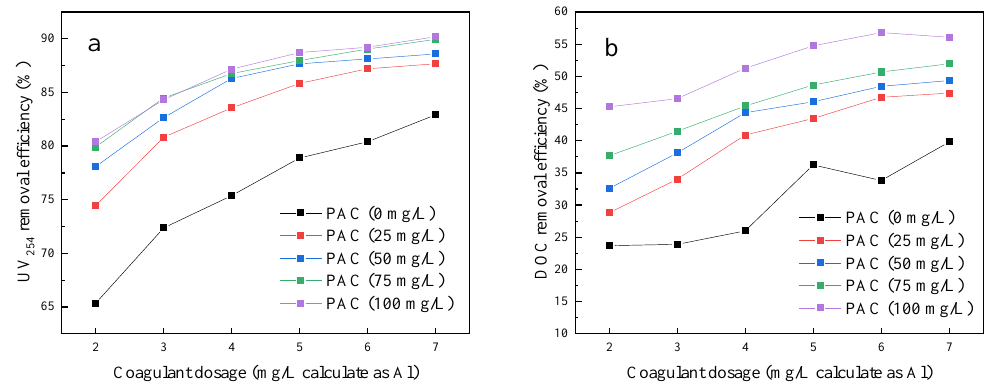
Figure 1. The pollutant removal efficiencies by the coagulation followed by adsorption (C-A) process ( a ) UV 254 removal efficiency ( b ) Dissolved organic carbon (DOC) removal efficiency.